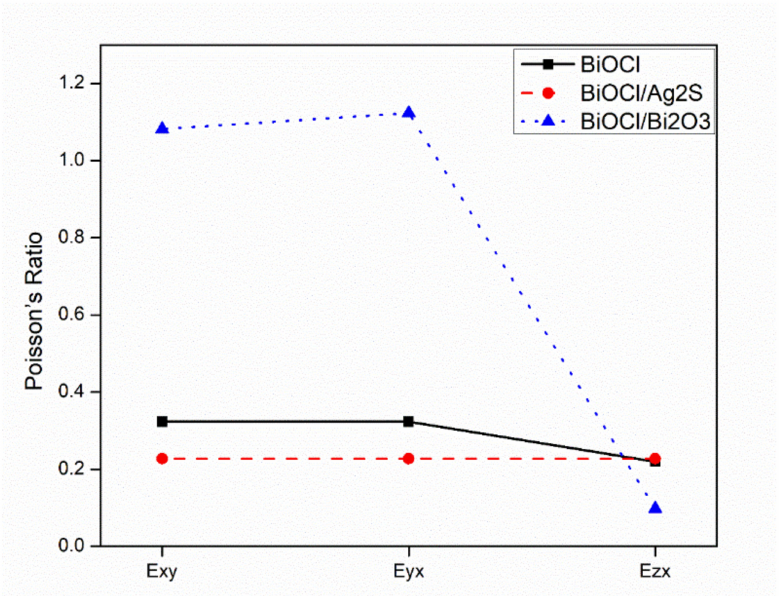
Figure 7. Poisson ratios of BiOCl, Bi 2 O 3 /BiOCl, and Ag 2 S/BiOCl in three directions (x, y, and